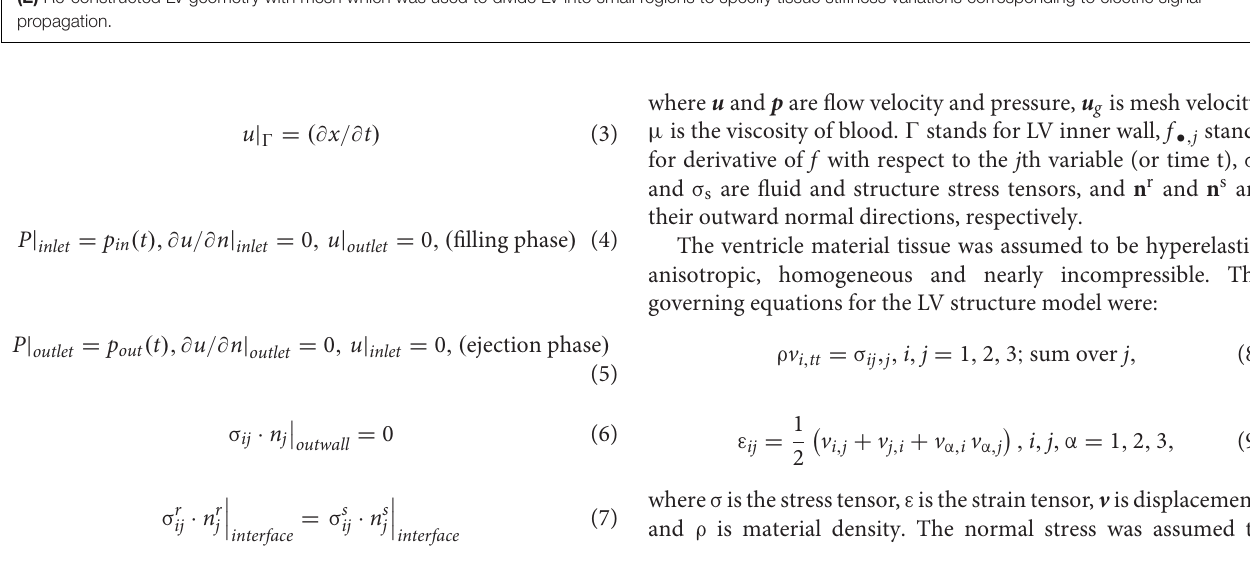
FIGURE 2 | Echo image of right ventricular apex (RVA) pacemaker, pressure profile, electric signal mapping and re-constructed left ventricular (LV) geometry with mesh. (A) End-Systolic Echo image, RVA. (B) Recorded LV blood pressure profile. (C) Imposed LV blood pressure profile. (D) Electric signal mapping, RVA model. (E) Re-constructed LV geometry with mesh which was used to divide LV into small regions to specify tissue stiffness variations corresponding to electric signal